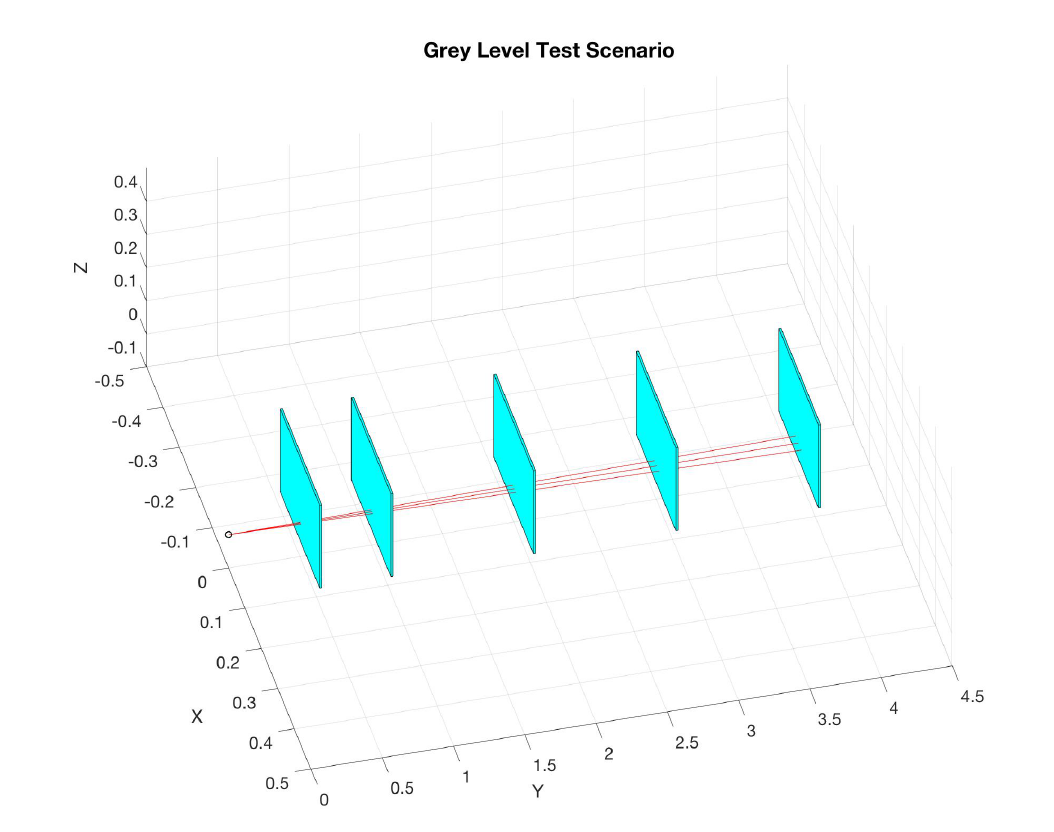
Figure 2. Illustration of target positions for the variable range based tests relative to laser source.